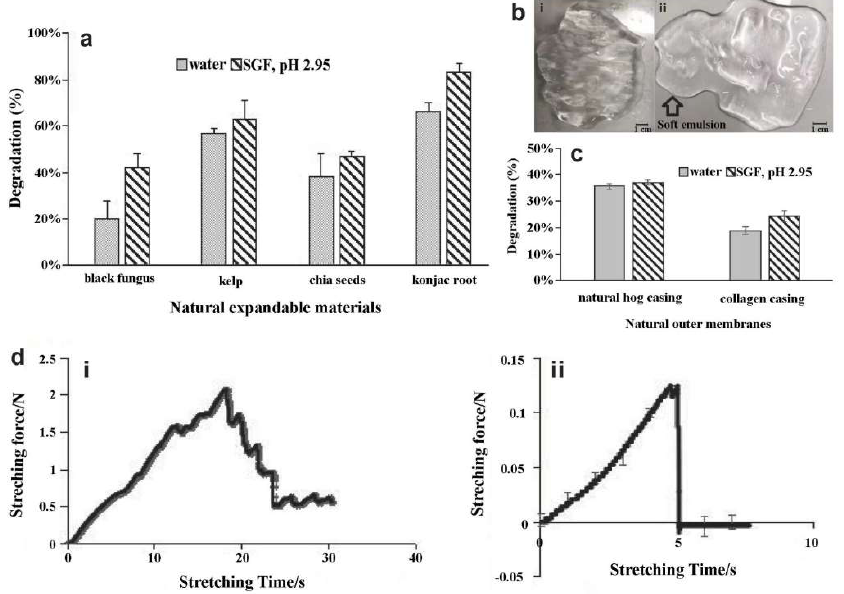
Figure 4. Degradation of EndoXpand capsules. ( a ) The degradation of four natural expandable materials (black fungus, kelp, chia seeds, and konjac root) upon submerging in pH 2.95 simulated gastric fluid (SGF) and pH 7 deionized water for 24 h. For each material, difference was found between the degradation in water and SGF ( p < 0.05). ( b ) Testing for 3D synthesized cellulose-based hydrogel bulking agents. (i) Hydrogel bulking agents immersed after 80 min in pH 2.95 SGF and maintained its 3D elastic gel structure. (ii) Hydrogel bulking agents immersed after 35 min in pH 7 distilled water, partially degrade (almost 50% degradation) and become a soft emulsion. ( c ) Degradation of the two membrane materials in pH 2.95 SGF and pH 7 deionized water at 37 ◦ C after 10 h submersion ( p < 0.05 for each material). ( d ) Stretch − force curves for corn silk fibers (i) without submersion in SGF and (ii) after submersion in SGF for 3 h. The force at the point of breakage is reduced by more than a factor 10. n =